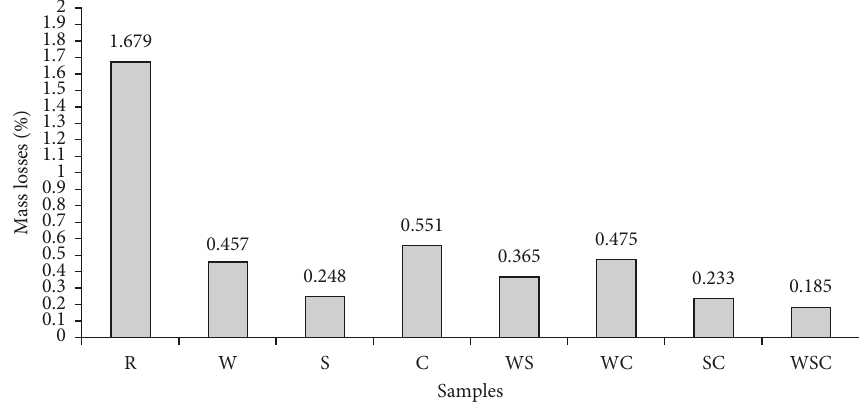
Figure 2: Mass losses of the reinforcement